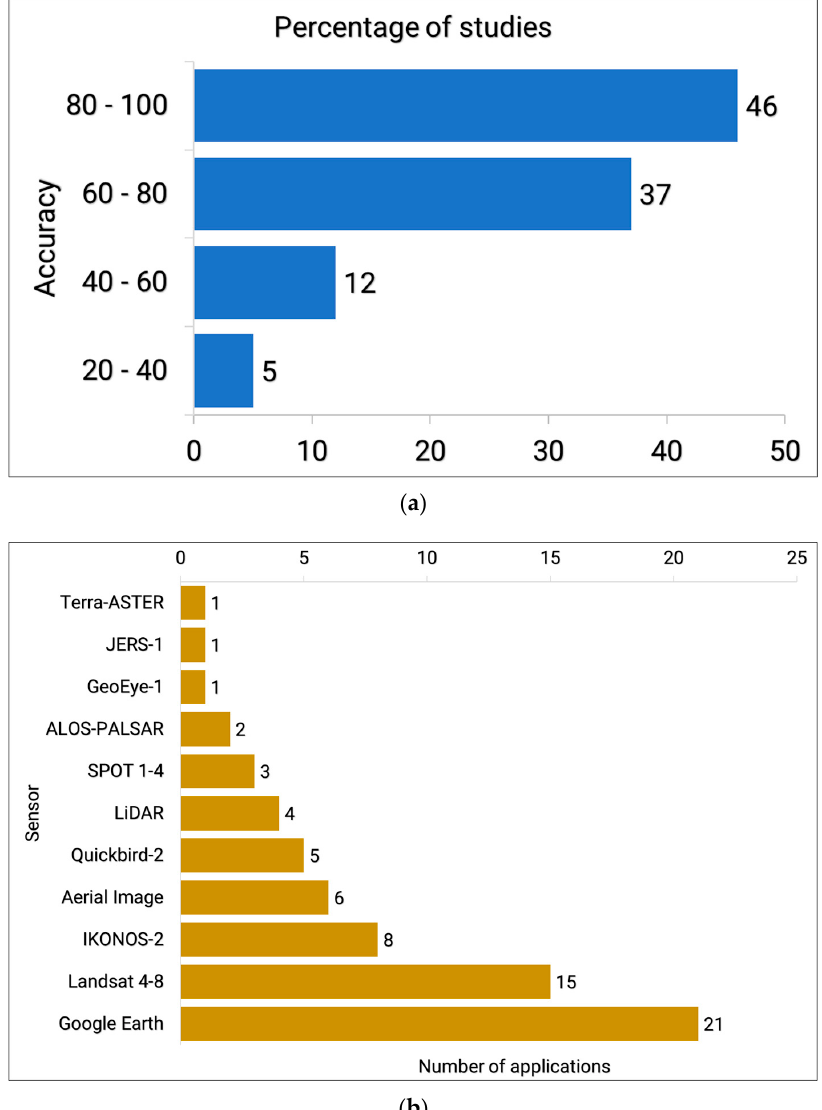
Figure 12. The percentage of studies per overall accuracy class ( a ) is shown only for those publications with overall accuracy clearly indicated, and ( b ) remote sensing data used in the validation process for those studies that reported an accuracy are shown.